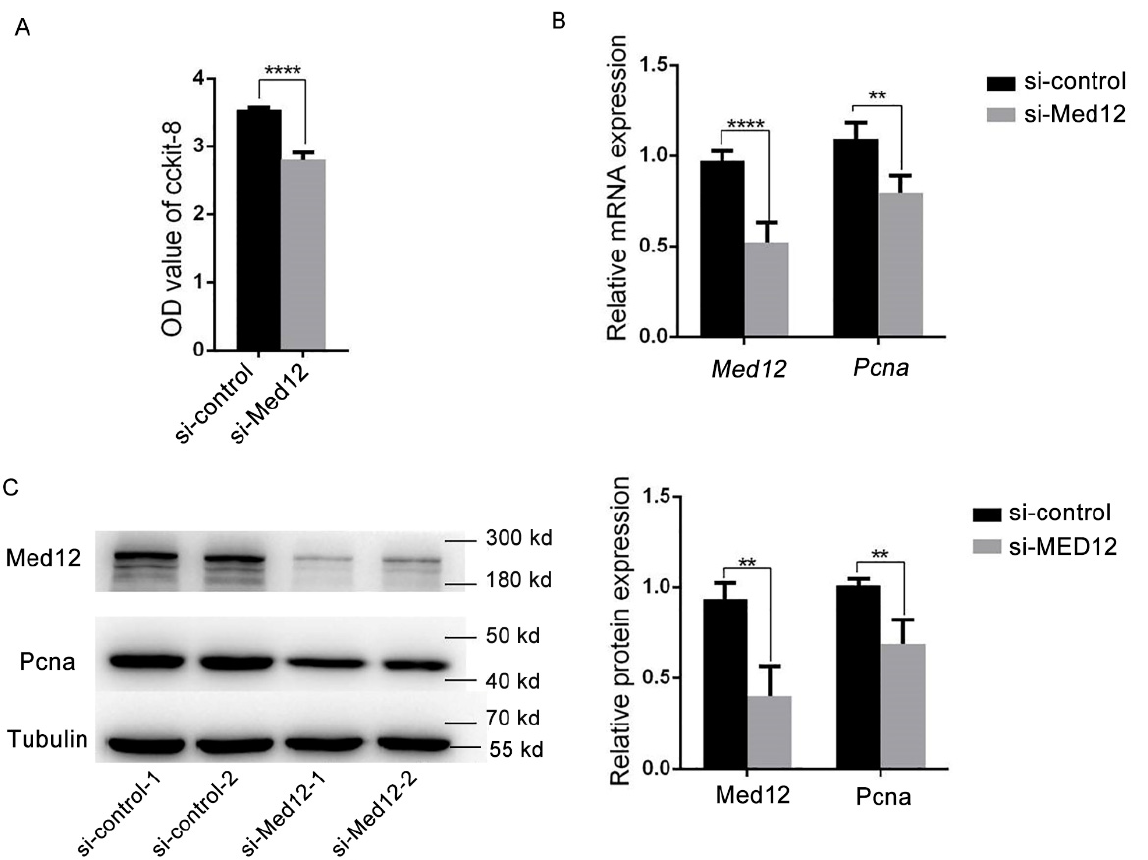
Figure 2. Decreased MED12 inhibited the proliferation of MOVAS. MOVAS transfected with si- control or si-Med12 for 72 h. ( A ) Cell viability detected by CCK-8. ( B ) Expression of Med12 and Pcna detected by RT-PCR. ( C ) Expression of MED12 and Pcna detected by Western blot. The experiment was repeated at least three times. Data are expressed as mean ± SD. Statistical analyses, unpaired t- test. ** p < 0.01; **** p < 0.0001.